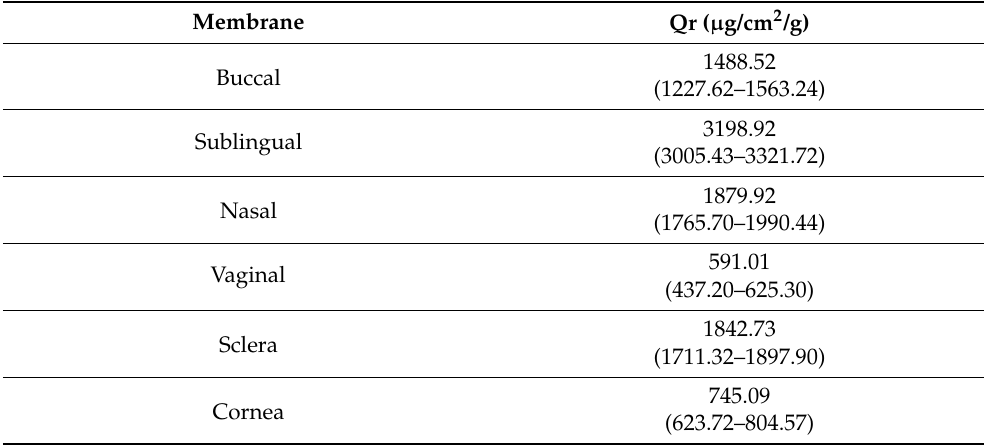
Table 12. The results of the retained amount (Qr) of pranoprofen at 6 h from the selected formula (PF-NLCs-N6) in the tissues (buccal, sublingual nasal and vaginal, cornea and sclera), n = 6 each. Values are reported as median (maximum and